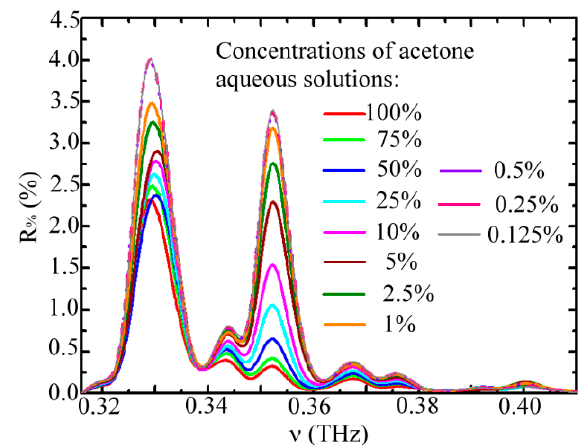
Figure 3. Reflectivity spectra of the WGS unit for various concentrations of acetone aqueous solutions. According to Equations (9)–(12), the loss coefficients of a WGS unit, α % , at the core mode frequencies are dominated by the molecular absorption of the acetone vapor. The criteria are the